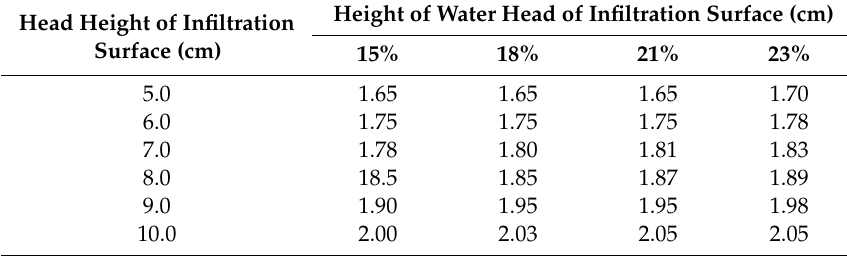
Table 5. Test results of head heights corresponding to di ff erent infiltration faces.